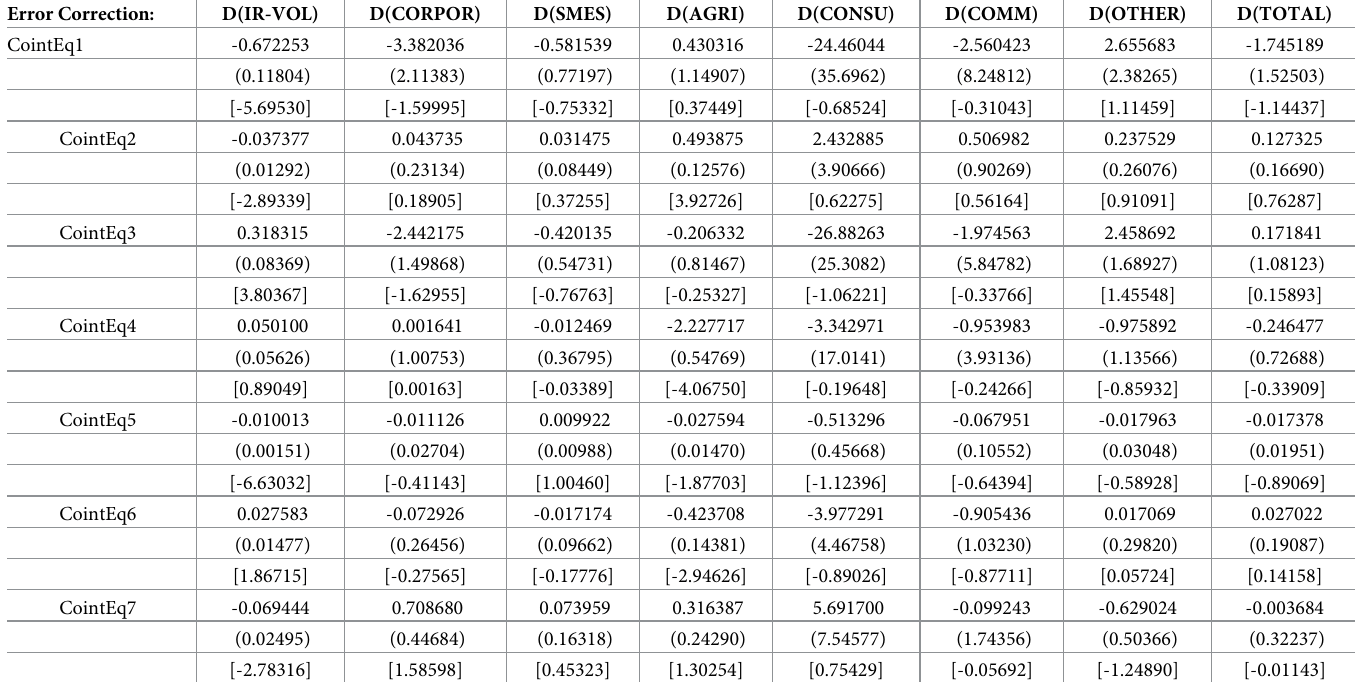
Table 4. Results of Vector Error Correction